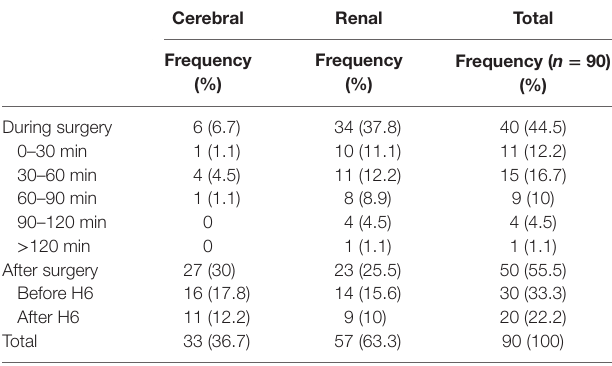
TaBle 3 | Cerebral and renal pathological rSO 2 values during or after surgery.